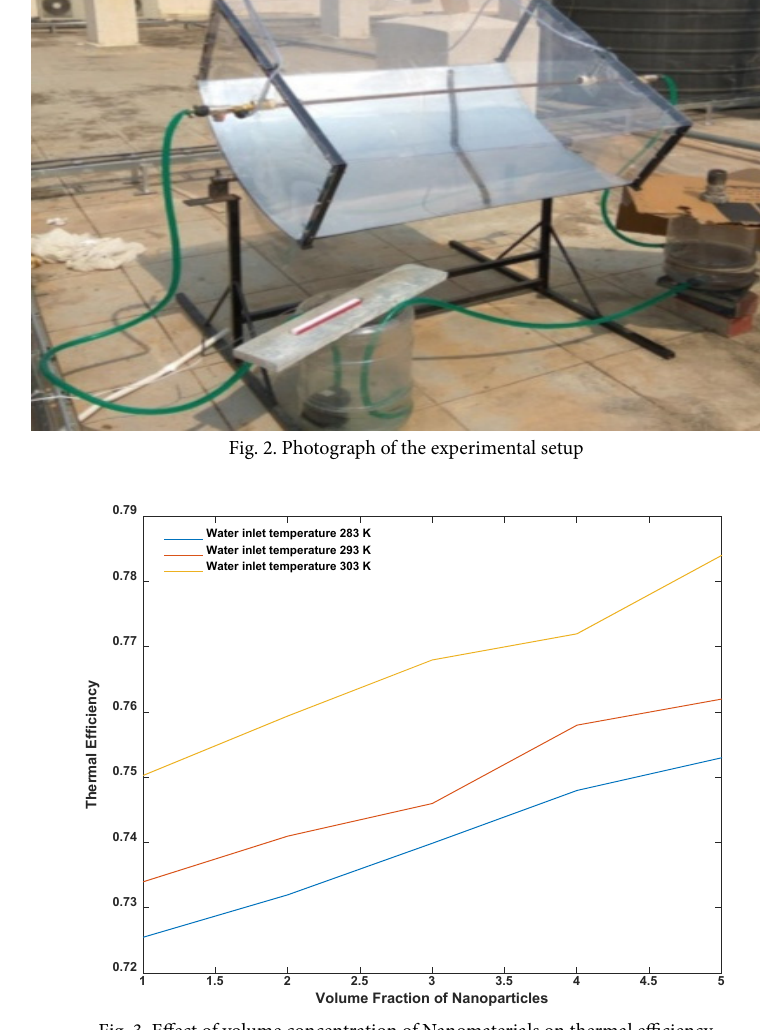
Fig. 3. Effect of volume concentration of Nanomaterials on thermal